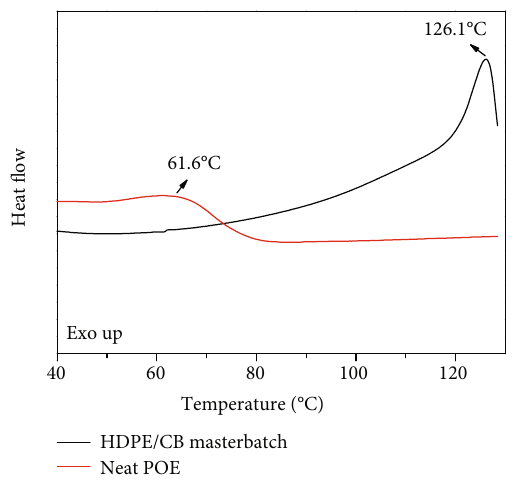
Figure 4: Plot of DSC analysis of HDPE/CB masterbatch and neat